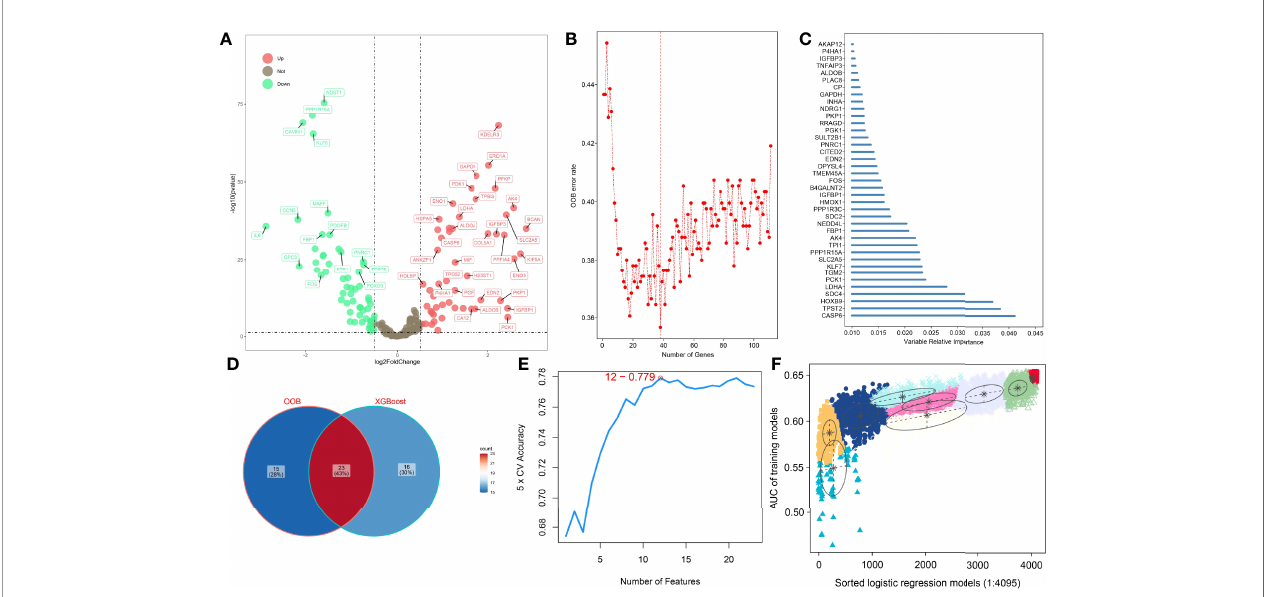
FIGURE 2 | Four machine learning algorithms were integrated to establish the HAGS. (A) The DEGs between the tumors group and normal tissues group were illustrated with a volcano plot. (B) Supervised random forest models were used to identify the top important hypoxia-related DEGs. (C) Top 39 features selected using XGBoost and the corresponding variable importance score. x-Axis indicates the importance score, which is the relative number of a variable that is used to distribute the data; y-axis indicates the top 39 weighted variables. (D) The intersection of the random forest model and the XGBoost model. (E) The SVM – RFE algorithms were used to further screen gene set. (F) The GMM was used to determine the fi nal